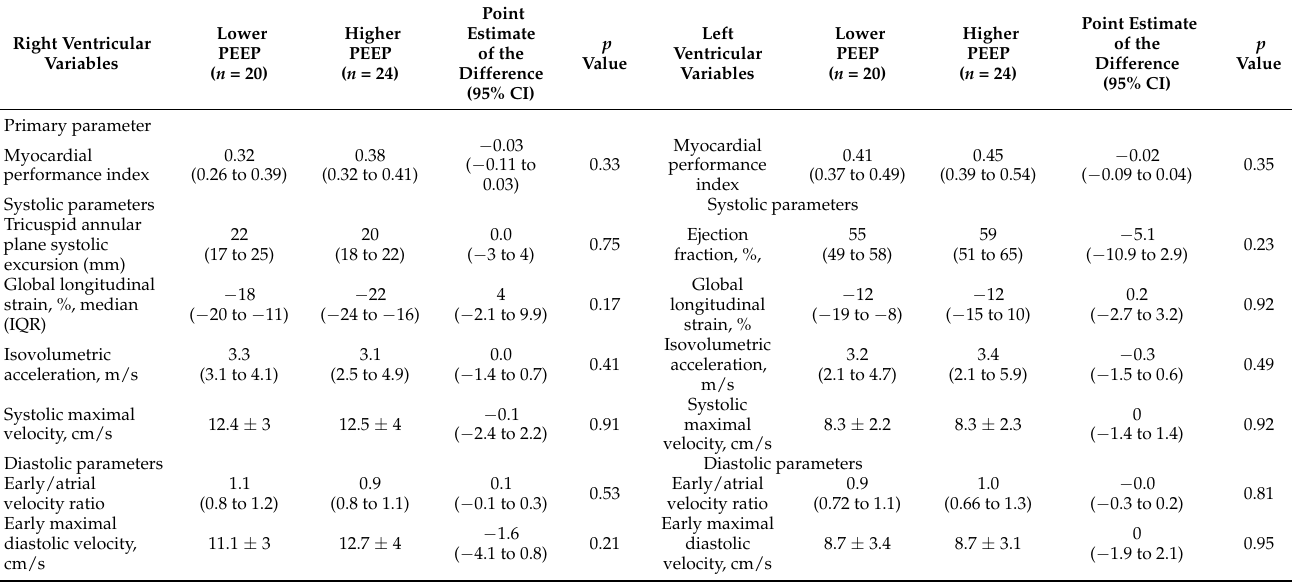
Table 3. Right and left ventricular systolic and diastolic